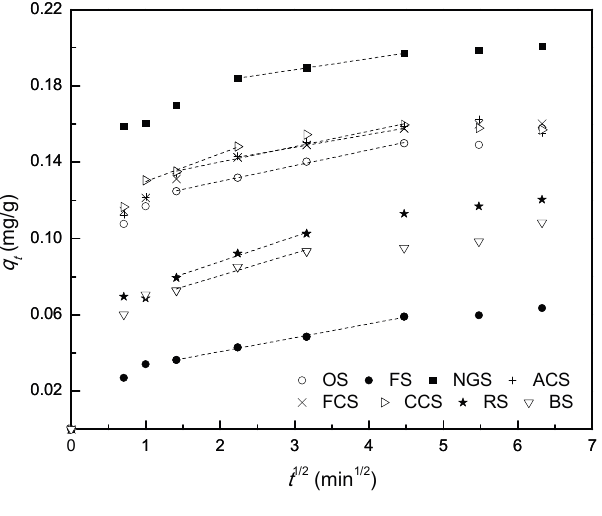
Figure 2. Intra-particle diffusion adsorption kinetics of phosphorus on soil. Notes: OS: orchard soils; FS: forest soils; NGS: natural grassland soils; ACS: abandoned cropland soils; FCS: furrowed cropland soils; CCS: cultivated cropland soils; RS: riparian soils; BS: bare